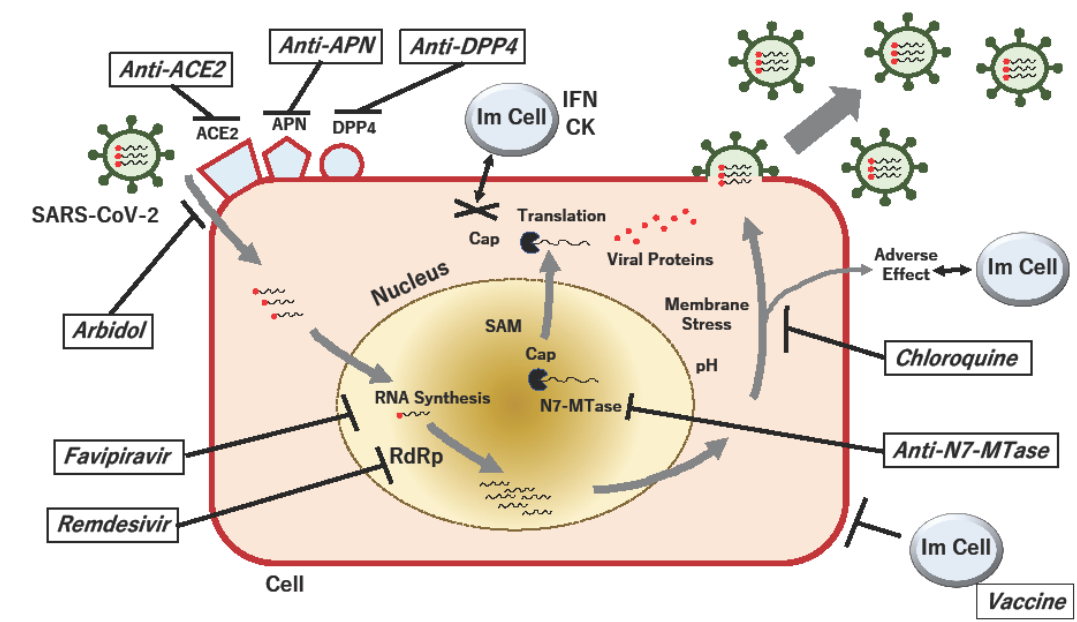
Figure 1. Proposed acting points of anti-SARS-CoV-2 in the replication cycle of the virus. When SARS-CoV-2 particles bind to their receptors, such as angiotensin-converting enzyme 2 (ACE2), aminopeptidase N (APN; CD13) and dipeptidyl peptidase 4 (DPP4; CD26), viral RNA is passed to the host cell, and RNA-dependent RNA polymerase (RdRp) produces viral RNAs. During RNA methylation, the RNA cap is formed, which protects against the host innate immune response, which involves the secretion of interferons (IFNs) and cytokines (CKs). The viral (guanine-N7)-methyltransferase (N7-MTase) plays a critical role in RNA capping, using the methyl donor S-adenosyl-methionine (SAM). The process of viral RNA synthesis and the translation of proteins is associated with pH-dependent membrane stress, which can elicit adverse effects against immune and non-immune cells. If the viral replication cycle is not inhibited and infected cells are not eradicated, packed viruses will be disseminated to other cells in the host. Proposed drugs and their possible acting points against COVID-19 are shown by bold lines.